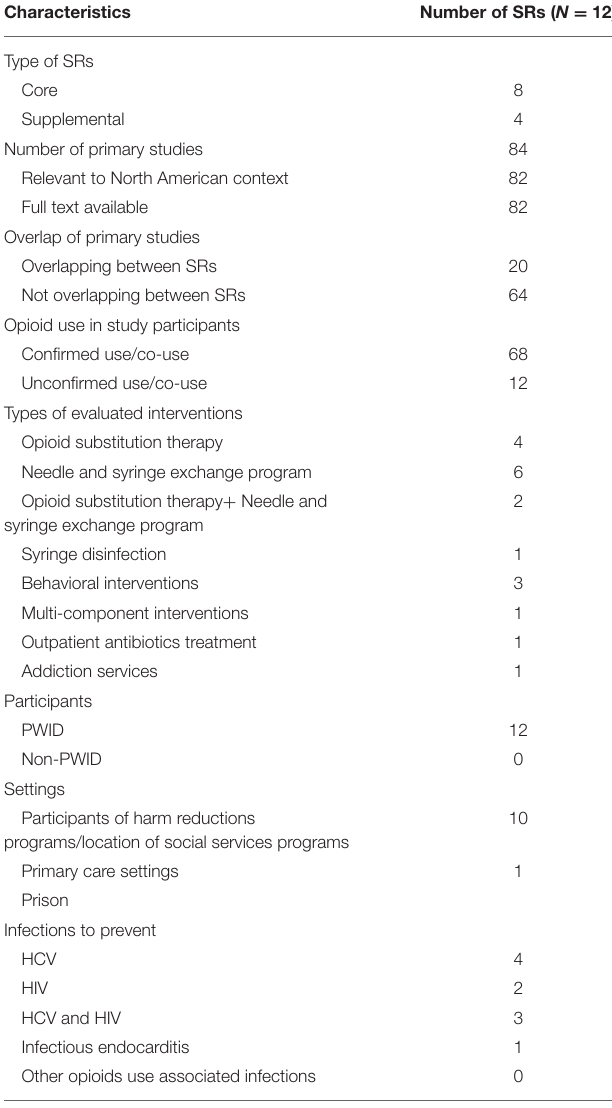
TABLE 3 | Characteristics of included systematic